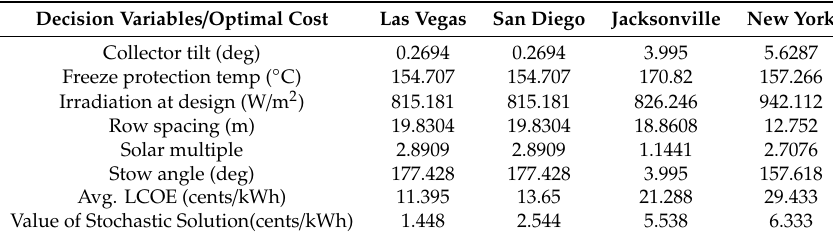
Table 4. Deterministic optimization